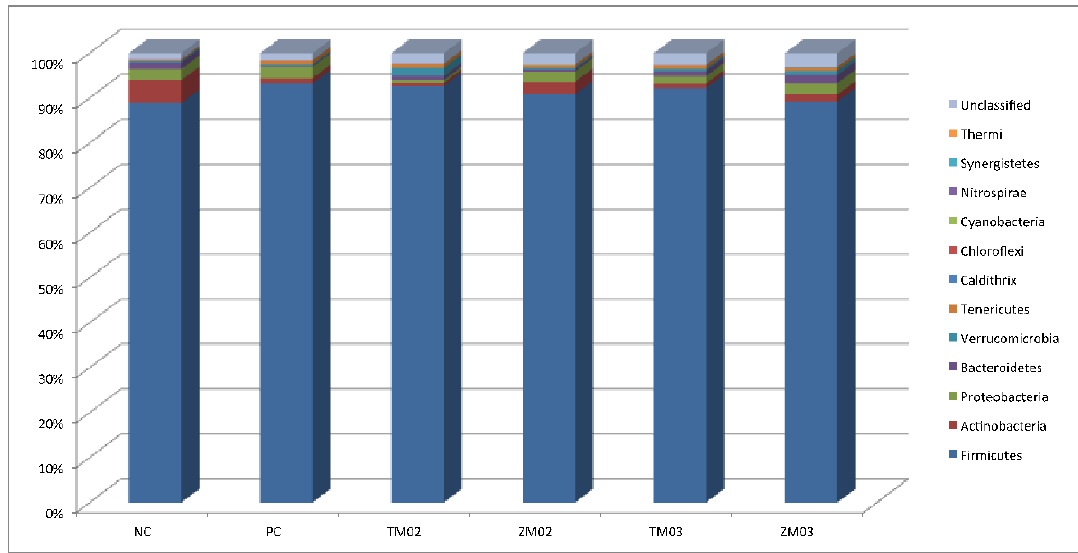
Figure 3. E ff ect of insect diet on chicken cecal microbiome composition at phylum-level. Legends refer to sample: PC—positive control (salinomycin, 60 ppm); NC—negative control (no